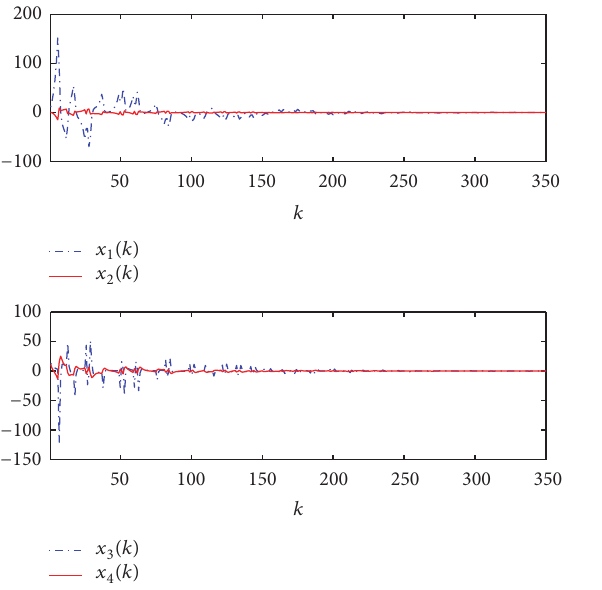
Figure 5: Asymptotic convergence of the system when 𝑁 = 60 under method I.